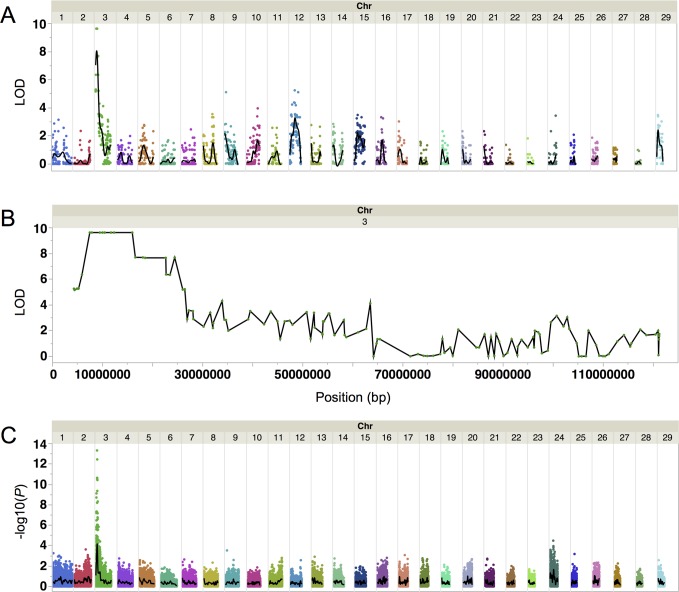
Linkage and genome-wide association mapping of Dominant Red.(A) Whole genome linkage mapping using a single half-sib family of 15 DR and 17 WT animals shows Dominant Red is located on BTA3. The black line is a cubic spline smoother with a lambda of 0.05. (B) Linkage mapping shows eight contiguous SNPs on BTA3 in complete association with Dominant Red across a 10.7 Mb region. (C) Genome-wide association analysis in 95 DR and more than 500 WT animals identifies a significant association on BTA3 within the 10.7 Mb region identified by linkage mapping. The most significant marker is ARS-BFGL-NGS-94819 @ 9,722,400 bp. The black line is a cubic spline smoother with a lambda of 0.05.